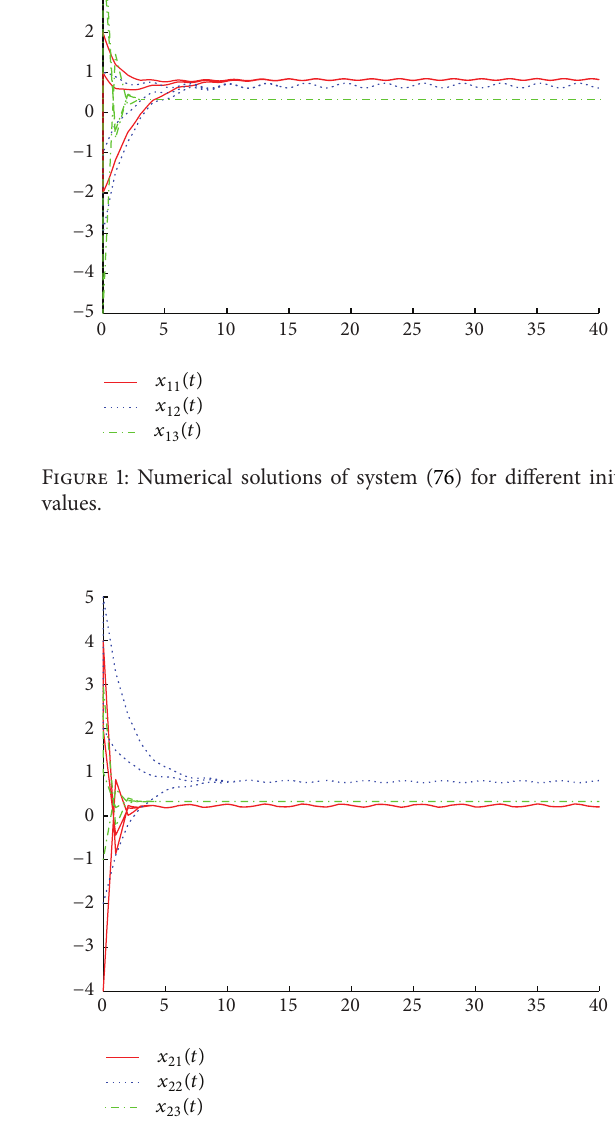
Figure 2: Numerical solutions of system (76) for different initial